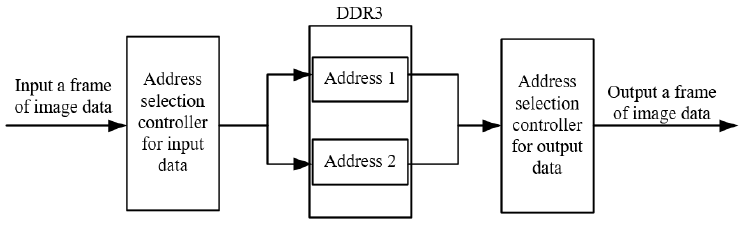
Figure 4. Schematic diagram of ping-pong operation of DDR addresses.